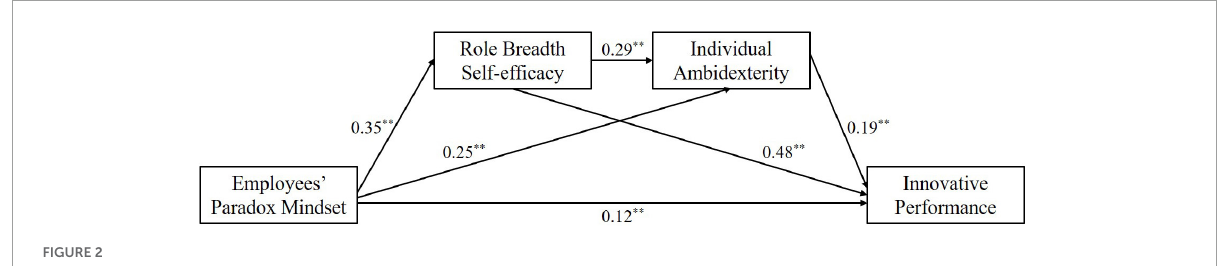
FIGURE2 Standardized estimates of the path